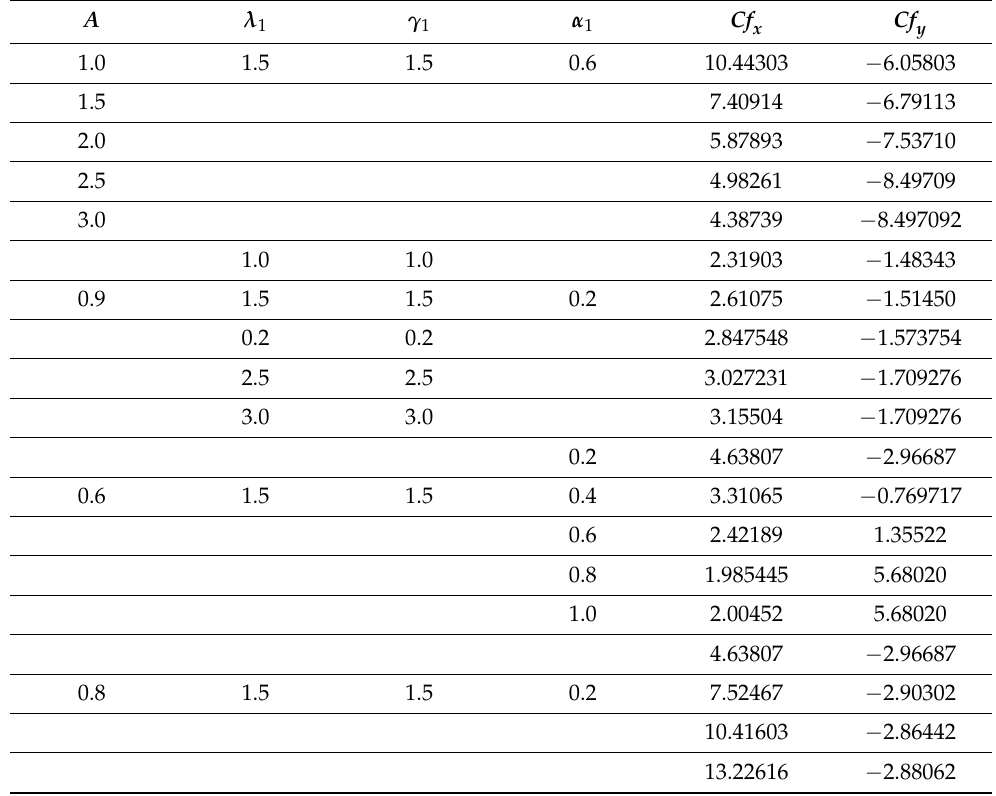
Table 1. Variation in skin friction for different